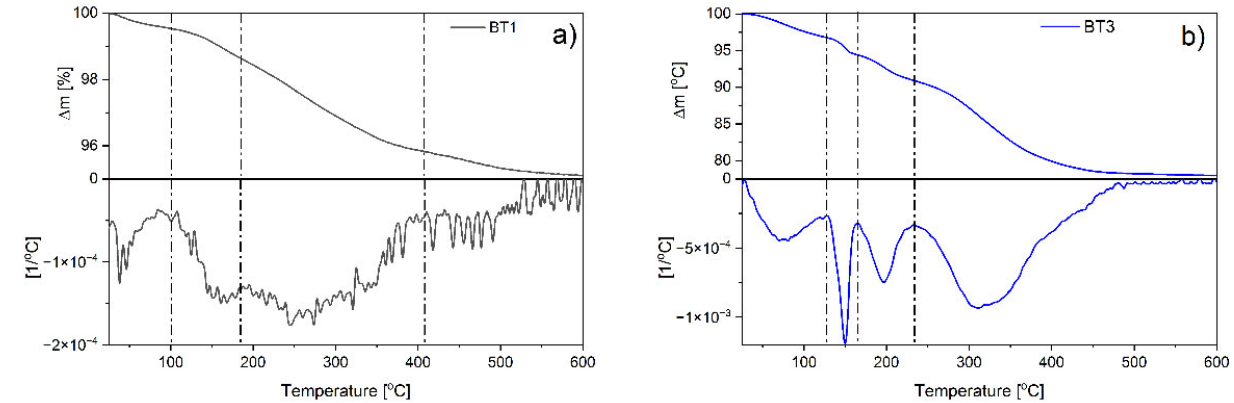
Figure 4. TG and DTG curves of: ( a ) BT1; ( b ) BT3 samples.